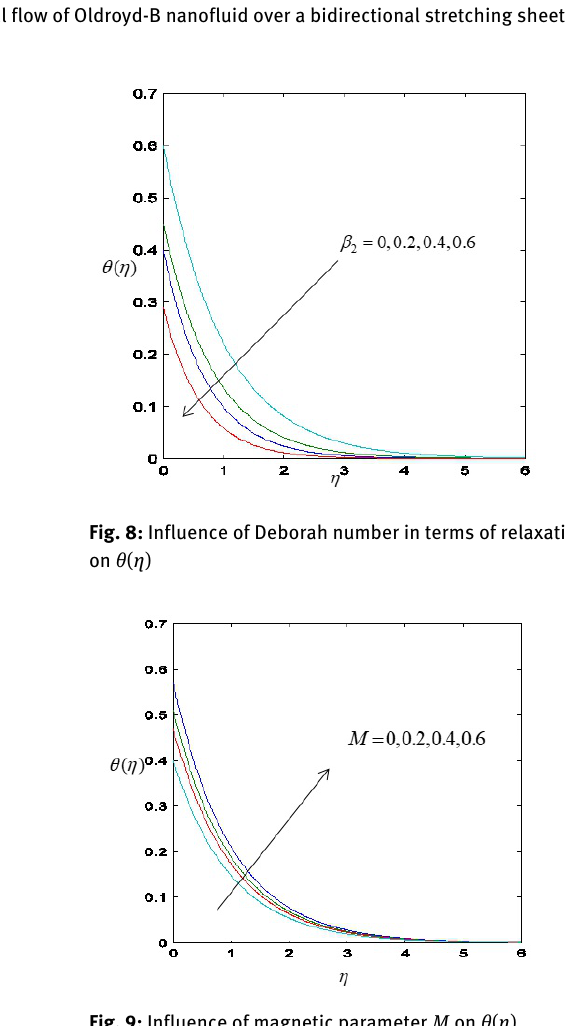
Fig. 9: Influence of magnetic parameter M on θ ( η )